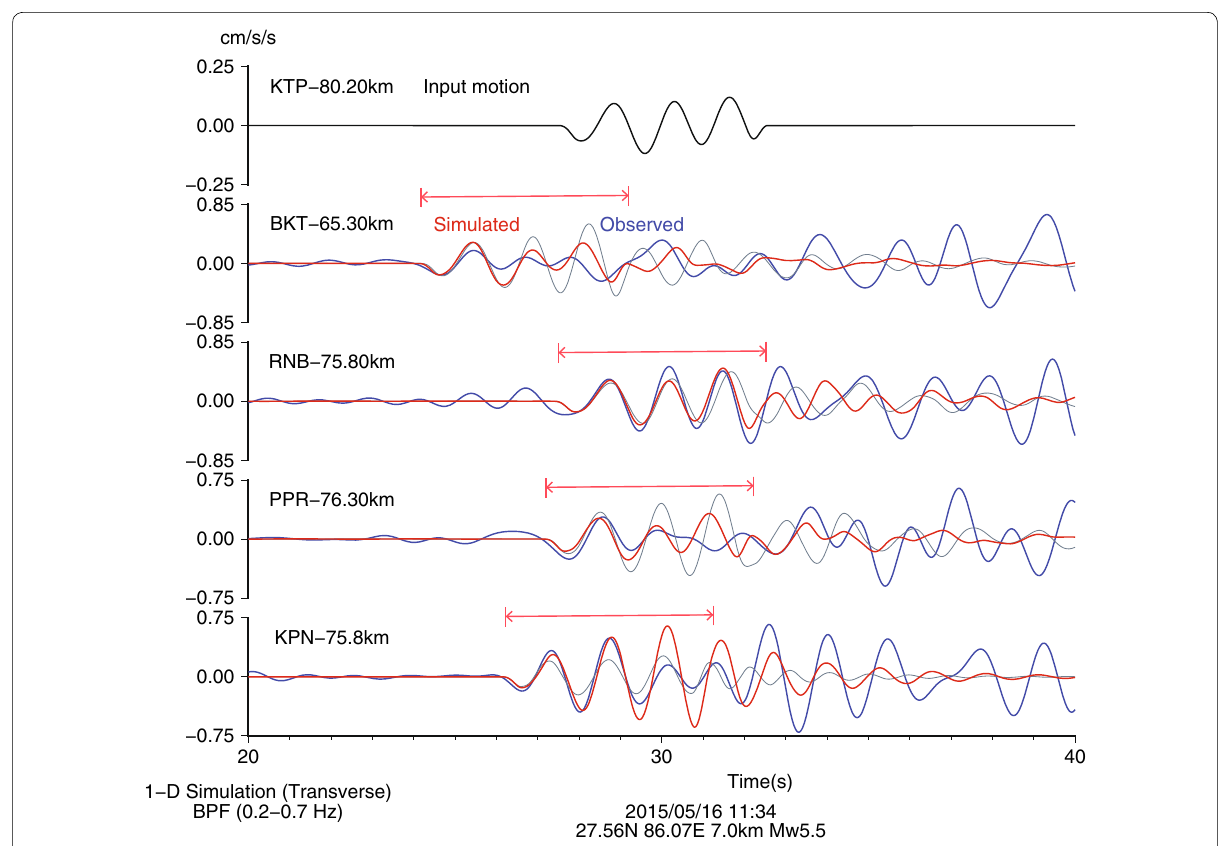
Fig. 15 Simulated and observed waveforms at the temporary sites for the Mw5.5 earthquake. Better agreement is provided in the results from the adjusted models ( red ) than from the initial model ( gray ). Waveform matching was conducted for time windows indicated by the red arrows